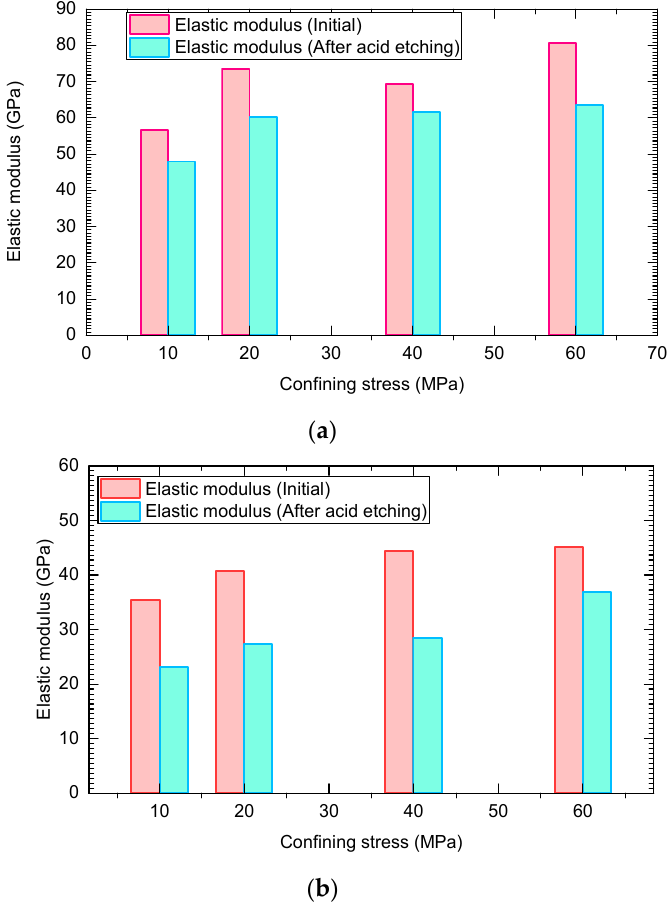
Figure 6. Cont Elastic modulus (Initial) Elastic modulus (After acid etching)